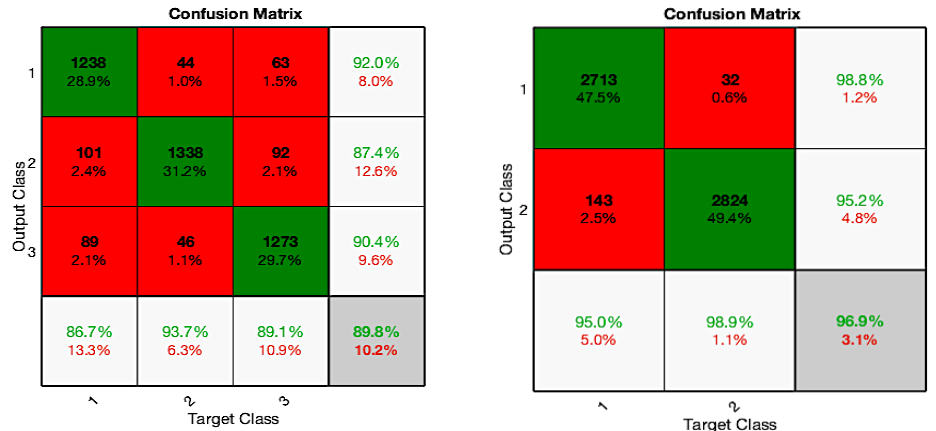
Figure 13. The confusion matrix for classifying two-class and three-class scenarios for F3 and C3 channels.